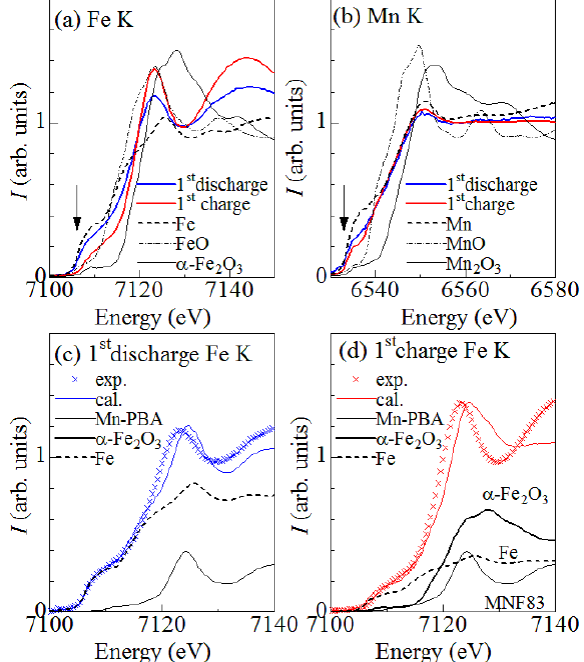
Figure 3. X-ray absorption spectra of discharged and charged films around the ( a ) Fe and ( b ) Mn K edges. The spectra of metal and oxides are also shown. Downward arrows indicate the absorption edge of the metal. Decomposition of Fe K edge spectra of ( c ) discharge and ( d ) charge films into the spectra of the as-grown film, α -Fe 2 O 3 and Fe